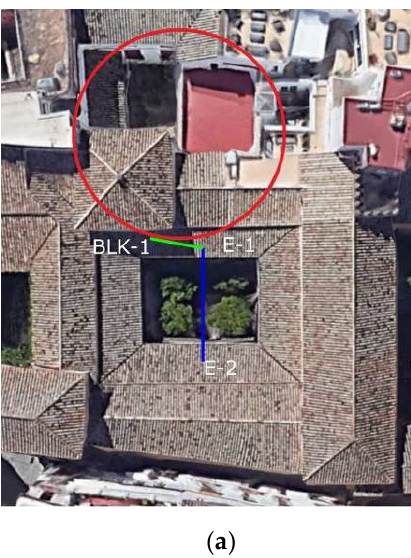
Figure 9. Scan path and distribution. ( a ) General view. ( b ) Fit and error values of the scans.